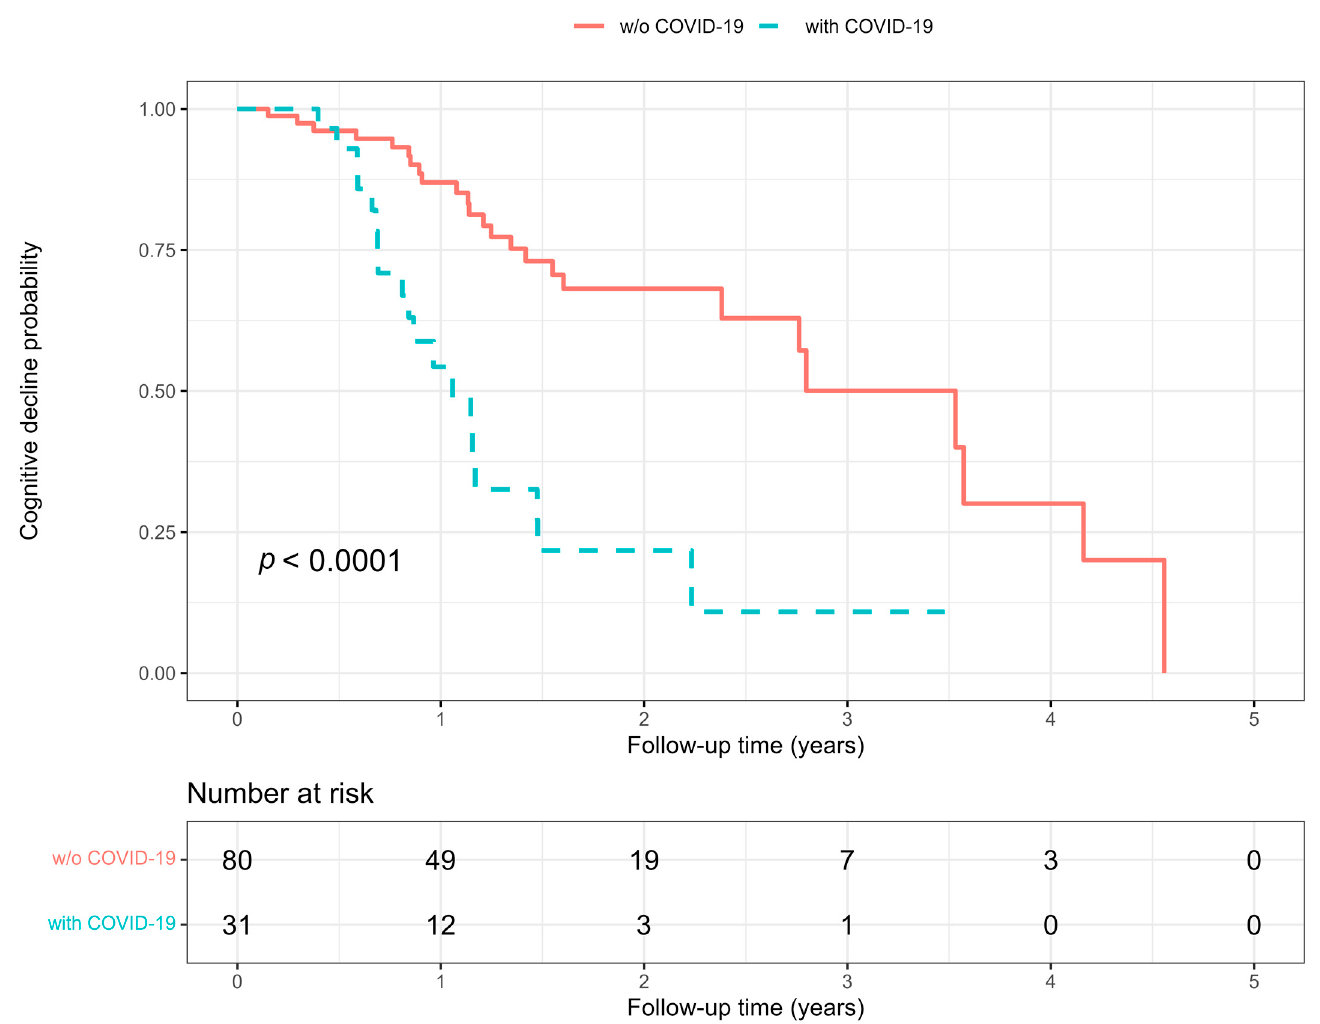
Figure 1. Kaplan–Meier curves of the probability of cognitive decline over time in elderly patients who had (cyan dashed line) or did not have (pink continuous line) COVID-19 between baseline and follow-up visits. Probability p was calculated with the nonparametric log-rank test. The number at risk are patients free from cognitive decline at a specific time point in either group.